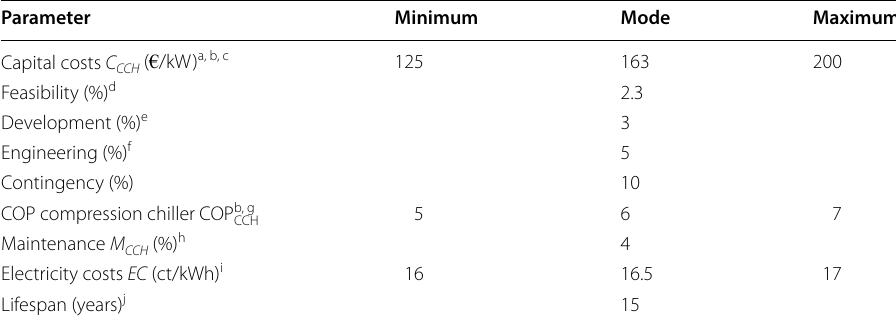
Table 7 Input parameters defining the capital costs C of the compression